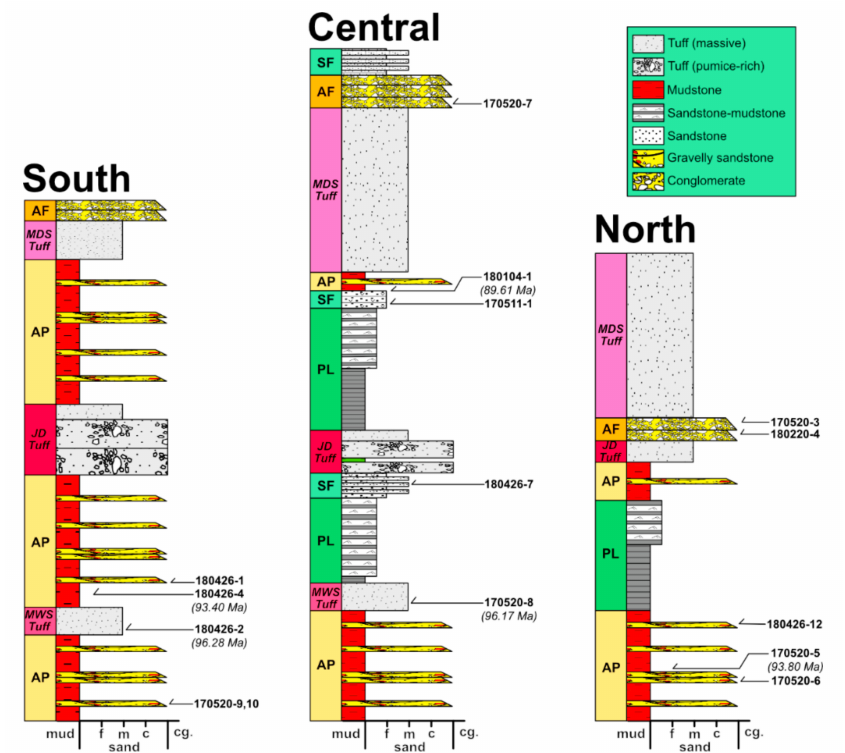
Figure 3. Schematic composite section of the study area (modified from [26]). AF = alluvial fan; AP = alluvial plain; SF = sandflat; PL = playa lake. The amalgamated tu ff beds of tens to hundreds